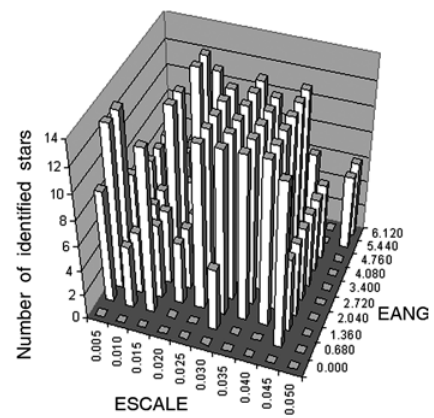
Fig. 3. Identification results (f16) by choosing stepwise values in parameter 1 ε (ESCALE) and 2 ε